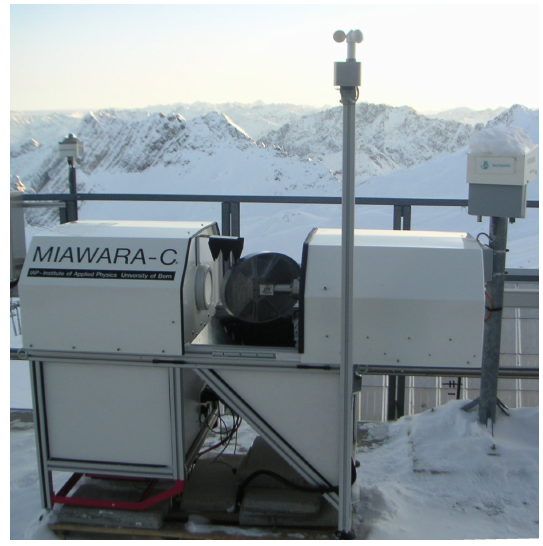
Fig. 1. MIAWARA-C during the ARIS-Campaign on the